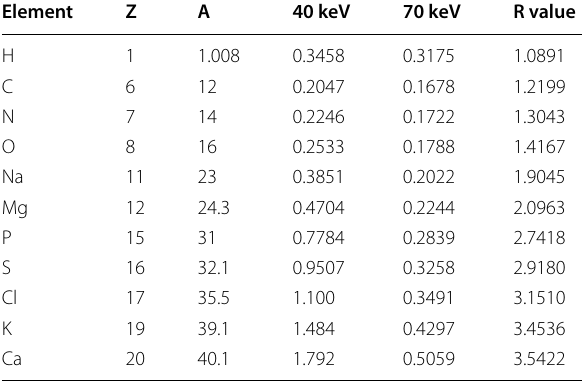
Table 4 R value according to the interaction between low and high energy X‑ray beams and the atomic number (Z) and mass (A) of each tissue